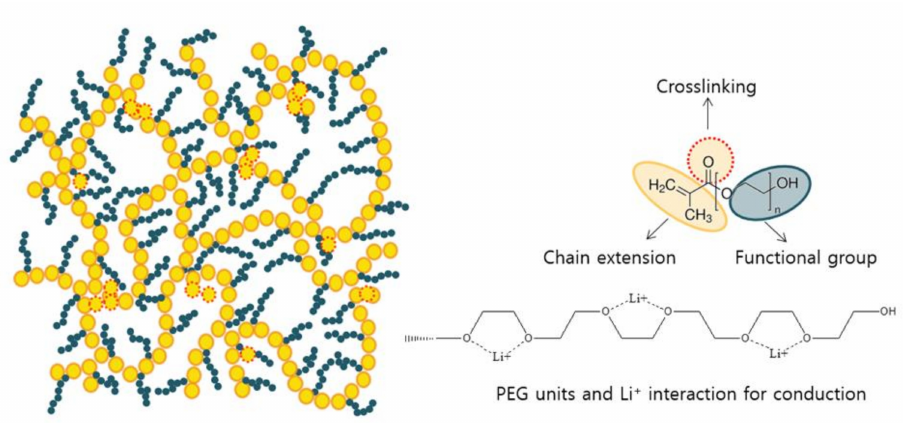
Figure 1. The schematic diagram of the gel polymer electrolyte reinforced membrane (GPERM) manufacturing